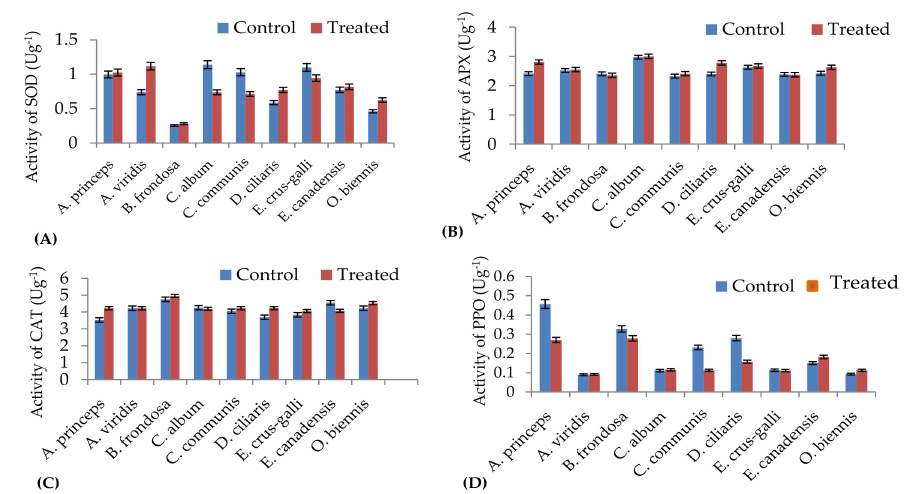
Figure 4. Comparison of antioxidant enzyme activities of weeds treated with Miscanthus extracts. ( A ), Superoxide dismutase (SOD); ( B ), Ascorbate peroxidase (APX); ( C ), Catalase (CAT); ( D ), Polyphenoloxidase (PPO). Values are reported as mean ± standard deviation of three parallel